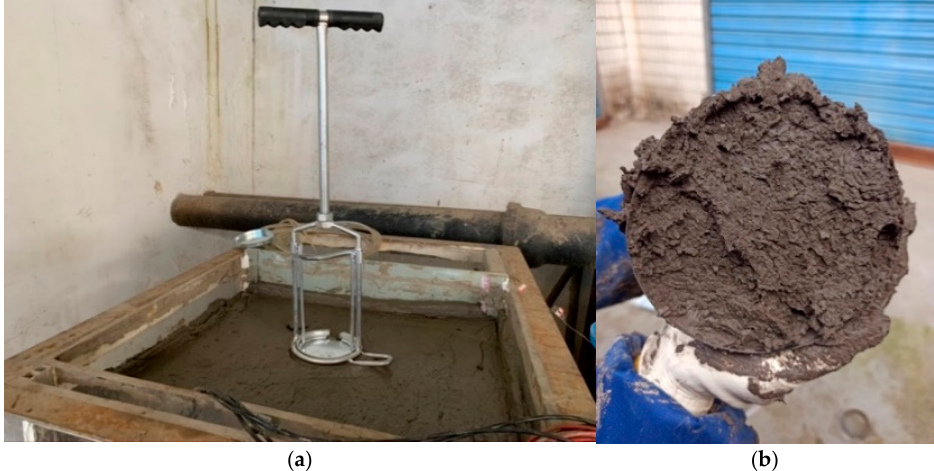
Figure 3. Sampling in model box. ( a ) Sampling and ( b ) sample bottom.